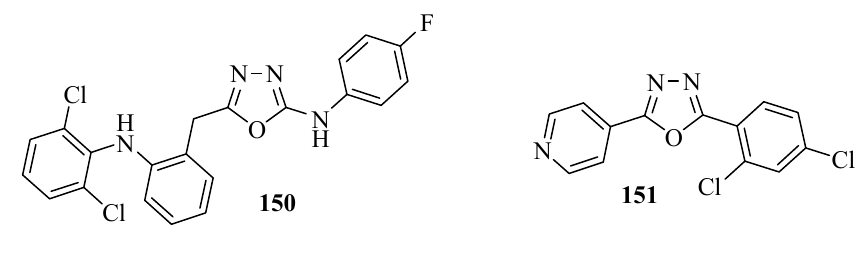
Figure 9. 1,3,4-Oxadiazoles with analgesic